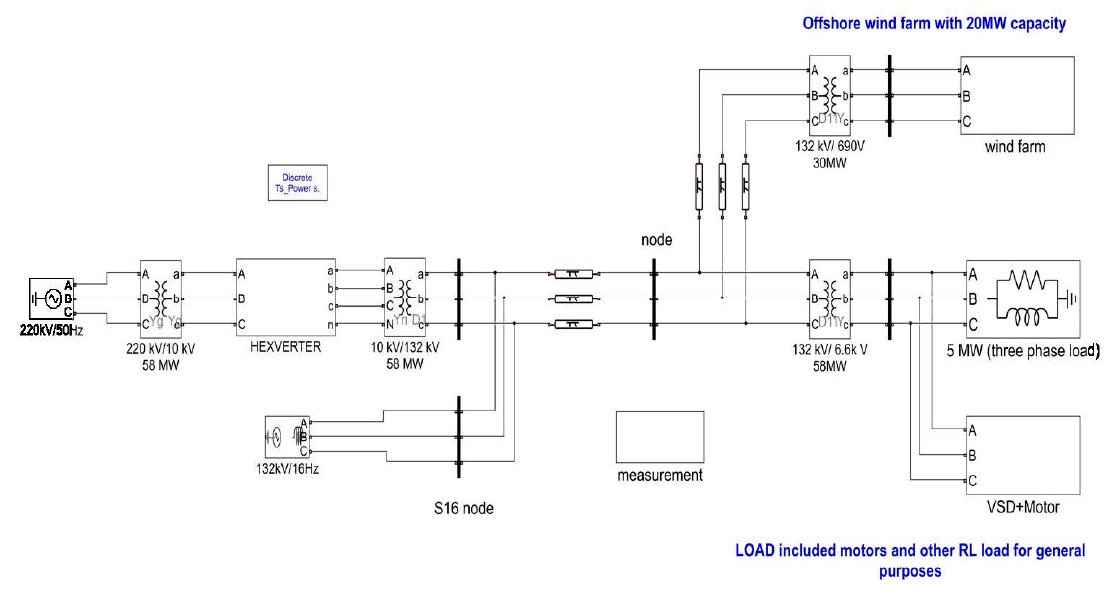
Figure 2. SIMULINK Model of Subsea T&D System.